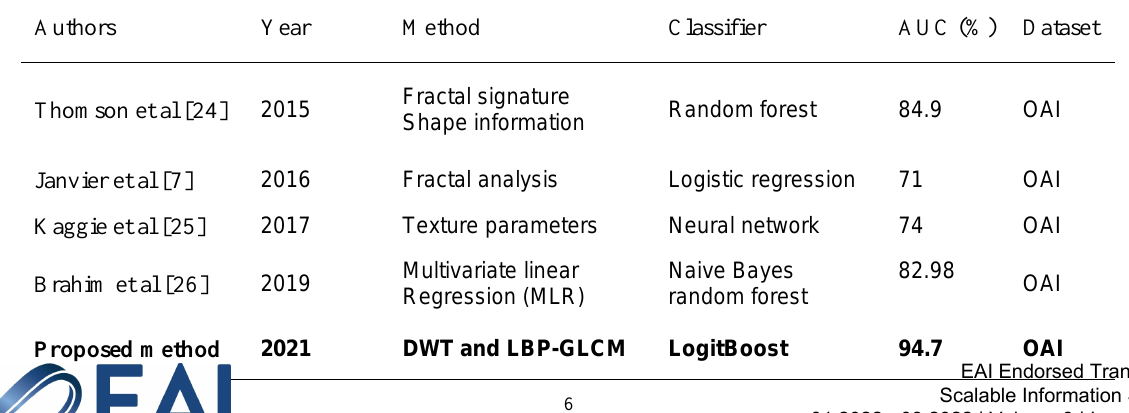
Table 5: Comparison of the proposed method with the existing studies in the